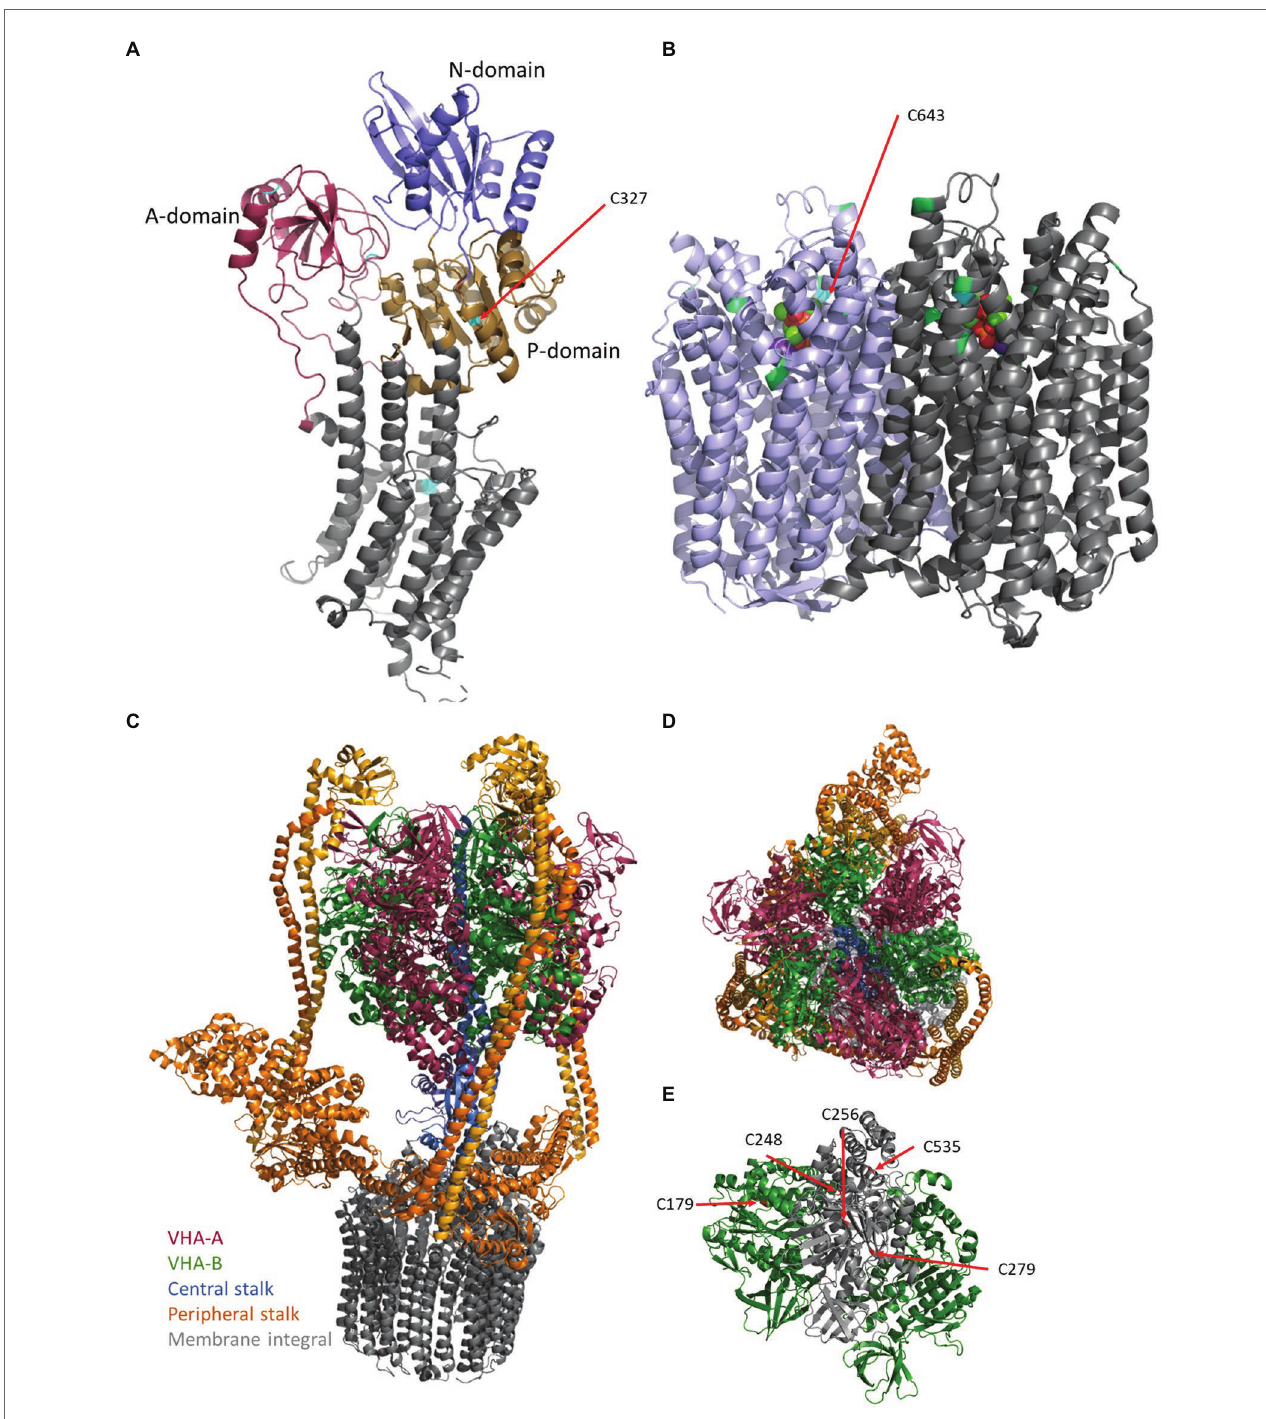
FIGURE 1 | Structures of the proton pumps. The structures of plasma membrane-ATPase (PM-ATPase) AHA2 of Arabidopsis thaliana (A) and vacuolar pyrophosphatase (V-PPase) from Vigna radiata (B) base on the pdb-files 5KSD (Croll and Andersen, 2016; Focht et al., 2017) and 6AFS (Tsai et al., 2019), respectively. (A) The PM-ATPase consists of 10 transmembrane domains and a large cytoplasmic C-terminal domain (Almeida et al., 2017; Nguyen et al., 2020). In detail, the structure of the cytosolic domain can be divided into the actuator- (A-domain), the nucleotide-binding- (N-domain), which is embedded in the phosphorylation domain (P-domain), and a disordered C-terminal region. ATP binds to the nucleotide-binding domain, which in turn moves closer to the phosphorylation domain, thereby forming the catalytic site. Cysteine residues are indicated by cyan coloring. (B) The V-PPase (EC 3.6.1.1) functions